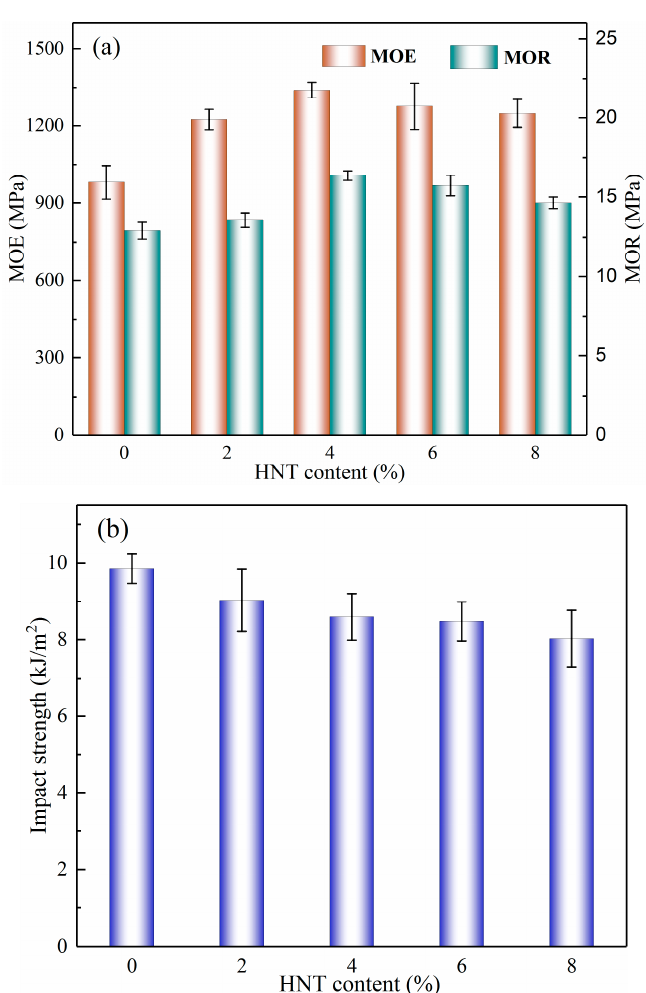
Figure 1. Mechanical properties of the bamboo–plastic composites (BPCs) with different contents of halloysite nanotubes (HNTs): ( a ) Flexural properties and ( b ) impact strength.